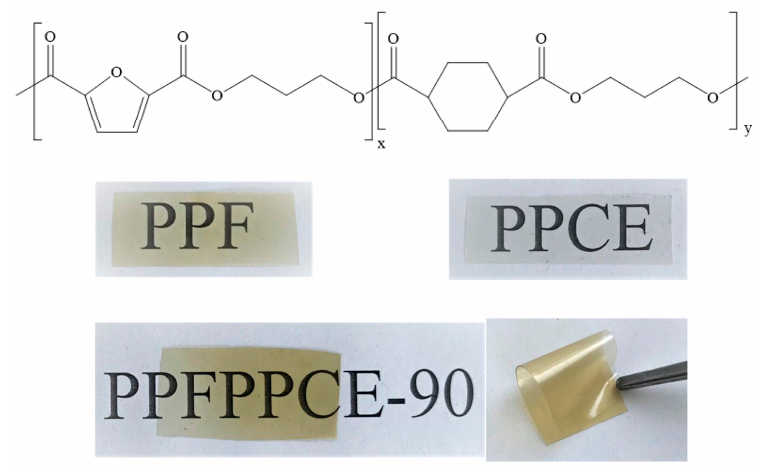
Figure 1. Chemical structure of PPFPPCE-t copolymers and pictures of compression-molded films of PPF, PPCE, and PPFPPCE-90.